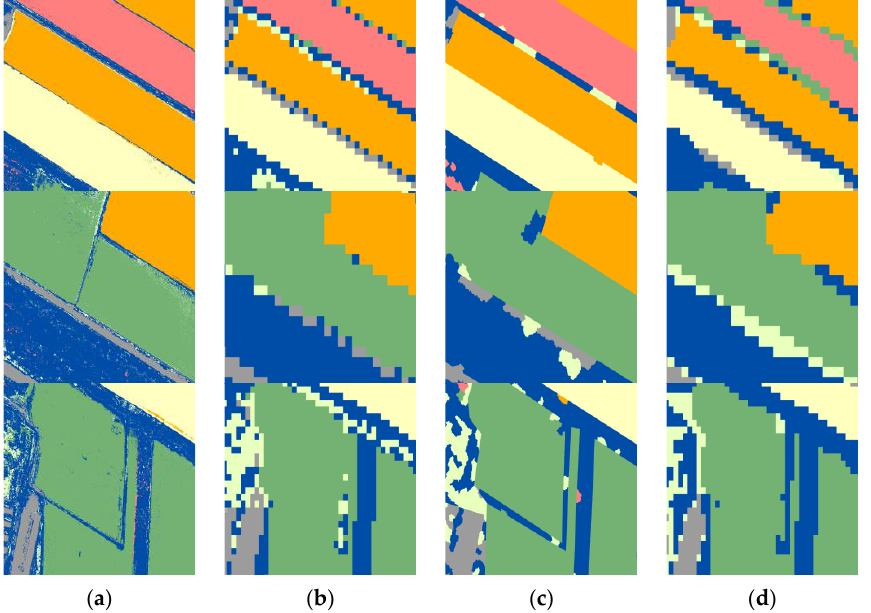
Figure 12. Local results of crop classification with different image types and different classification methods. Note: ( a ) pixels+UAV, ( b ) pixels+Satellite, ( c ) object-oriented+UAV, ( d ) object-oriented+Satellite.